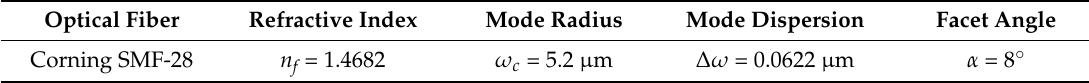
Table 1. Parameters of the optical fiber.